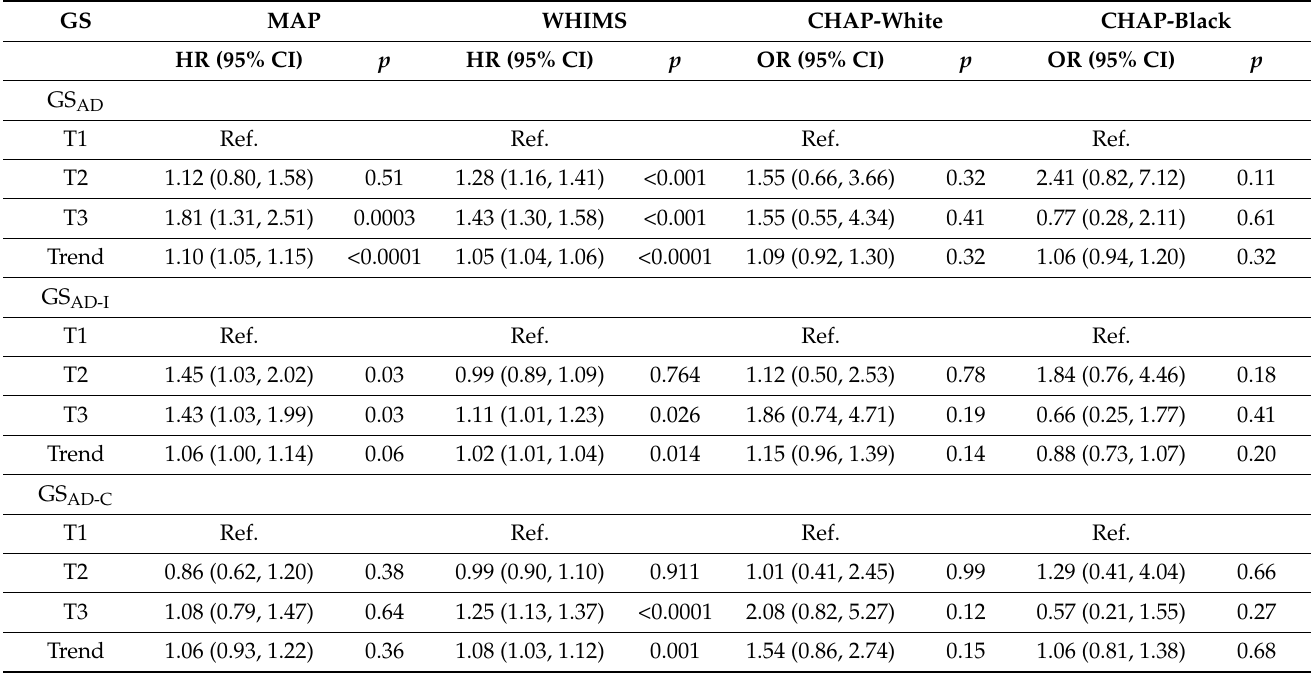
Table 4. GS and risk of all-cause dementia 1 .